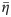
Predicting HIV-1 antibody neutralization curves and IC50.(A) Scheme depicting the virus and nAb-specific parameters necessary to predict HIV-1 neutralization by nAbs in silico. (B) to (D) Predicted HIV-1 nAb neutralization curves in dependence of (B) nAb KD, (C) HIV-1 entry stoichiometry, T, and (D) mean viron trimer number, η¯. (E) Dependence of nAb IC50 on the number of Env trimers required for HIV-1 cell entry, T. (F) Relation between HIV-1 virion population size and the fraction of Env subunits that need to be bound by nAb to achieve virus population neutralization. (G) Comparison of experimental nAb IC50 values measured with HIV-1 strain BG505 [47, 48] (S5 Table) and IC50’s predicted by our model using BG505-specific T, η¯ and KD [49] values (S3 and S5 Tables). For nAb PGT145 we assumed that only 1 nAb can bind per trimer; the PGT145 IC50 estimates with the 3-nAb-per-trimer model, used for all other nAbs, are shown in light grey (see also panel H). (H) For most nAbs, we assume that three nAbs can bind each trimer, while binding of one nAb is already sufficient for neutralization (N = 1). Binding of nAbs to a trimer that is already neutralized constitutes unproductive binding and may reduce antibody concentrations to a subcritical level [27]. To quantify this effect, we predicted neutralization by two nAbs with equal KD, but assuming that either three nAbs can bind each trimer, or that nAb binding is anti-cooperative as observed for PG9/PGT145-like nAbs, which are known to occupy only one of three potential epitopes per trimer. We observed a slight neutralization advantage for PG9/PGT145-like nAb binding behavior, manifested as an approximately two-fold reduction in predicted nAb IC50.